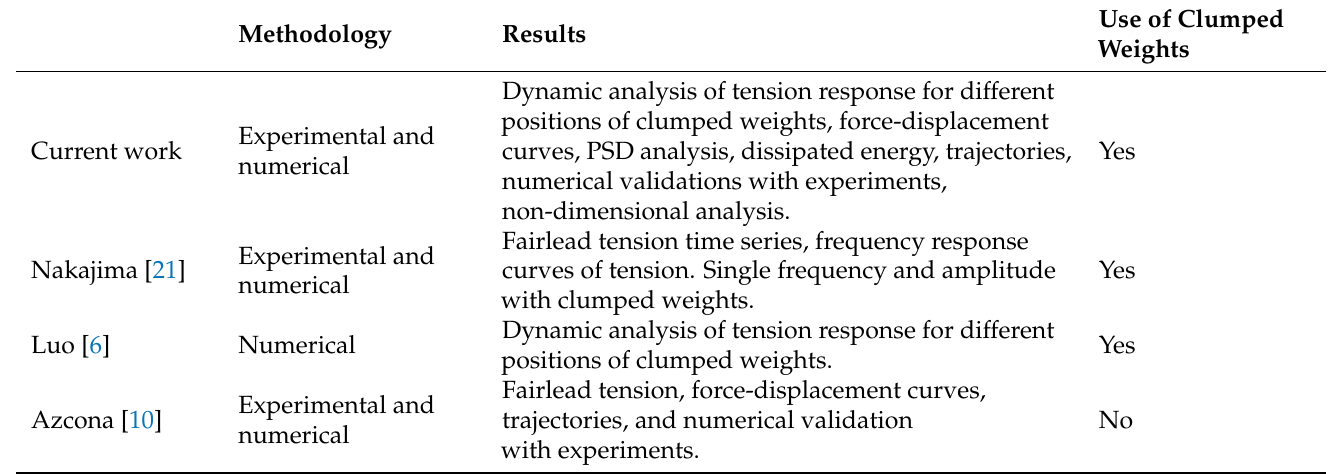
Table 1. Comparison table of the existing research literature of mooring lines forced oscillations and the present